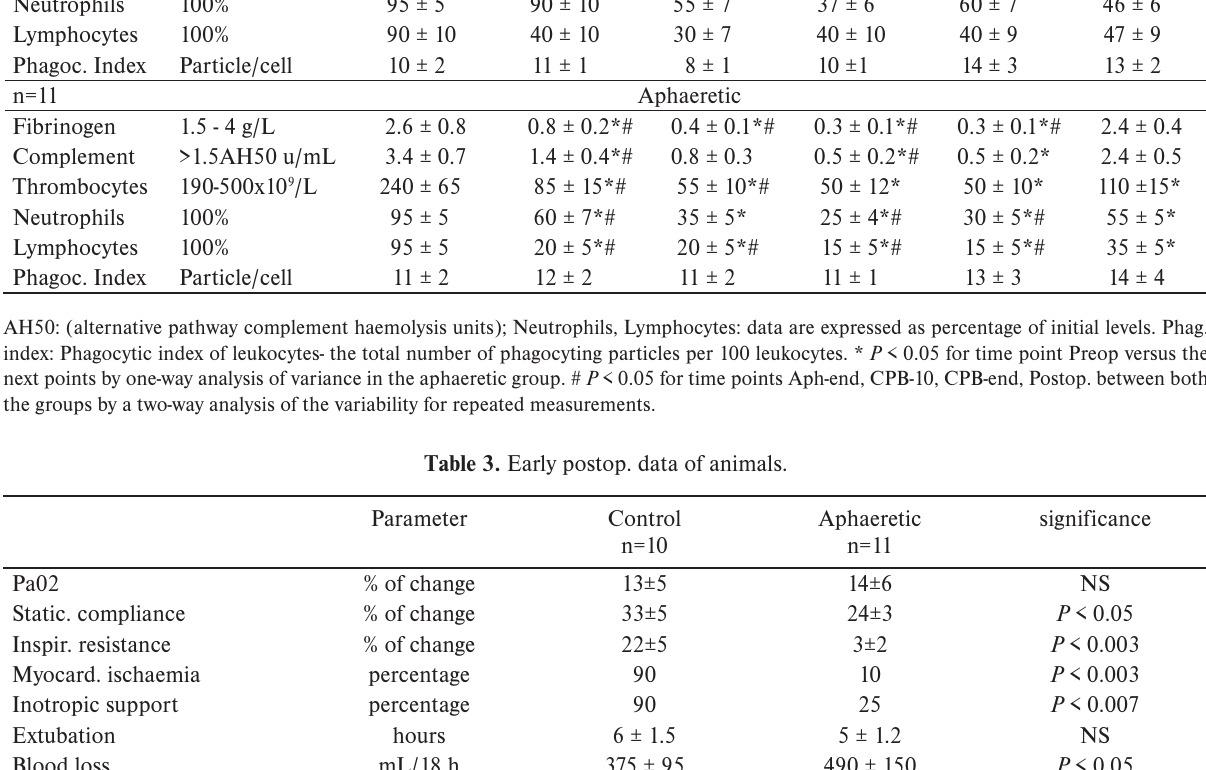
locytes by the measurement of superoxide anion produc- tion and surface neutral protease activity. The superoxide anions were increased in the control group as early as when cpB was initiated, and they increased to as much as 100% of their initial level, whereas in the aphaeretic group minimal production was recorded during the operative phase. during the early postoperative phase, however, this trend reversed, and the increase in activity was signifi- cantly higher in the aphaeretic group during the first two postoperative days. a similar trend was observed for the second marker of neutrophil activation, i.e., the surface neutral proteases. The phagocytic activity of the neutro- phils was not affected in both groups; there was only a